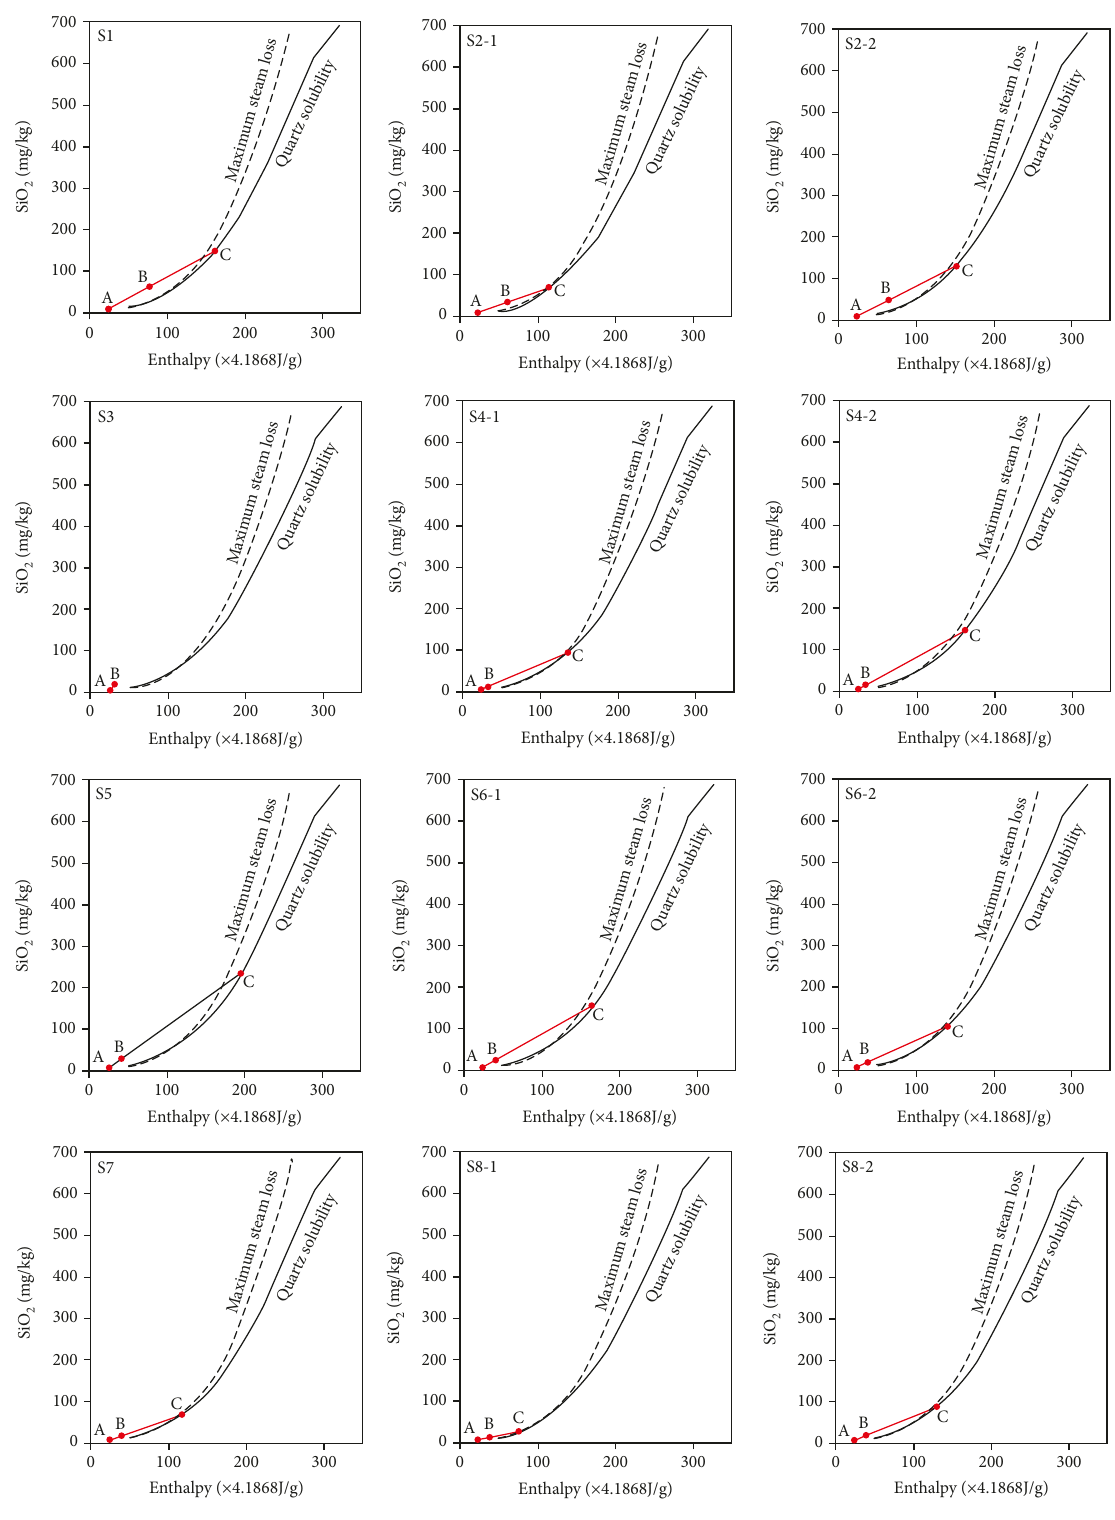
Figure 14: Dissolved silica-enthalpy diagram showing the hot spring water samples in the Simao